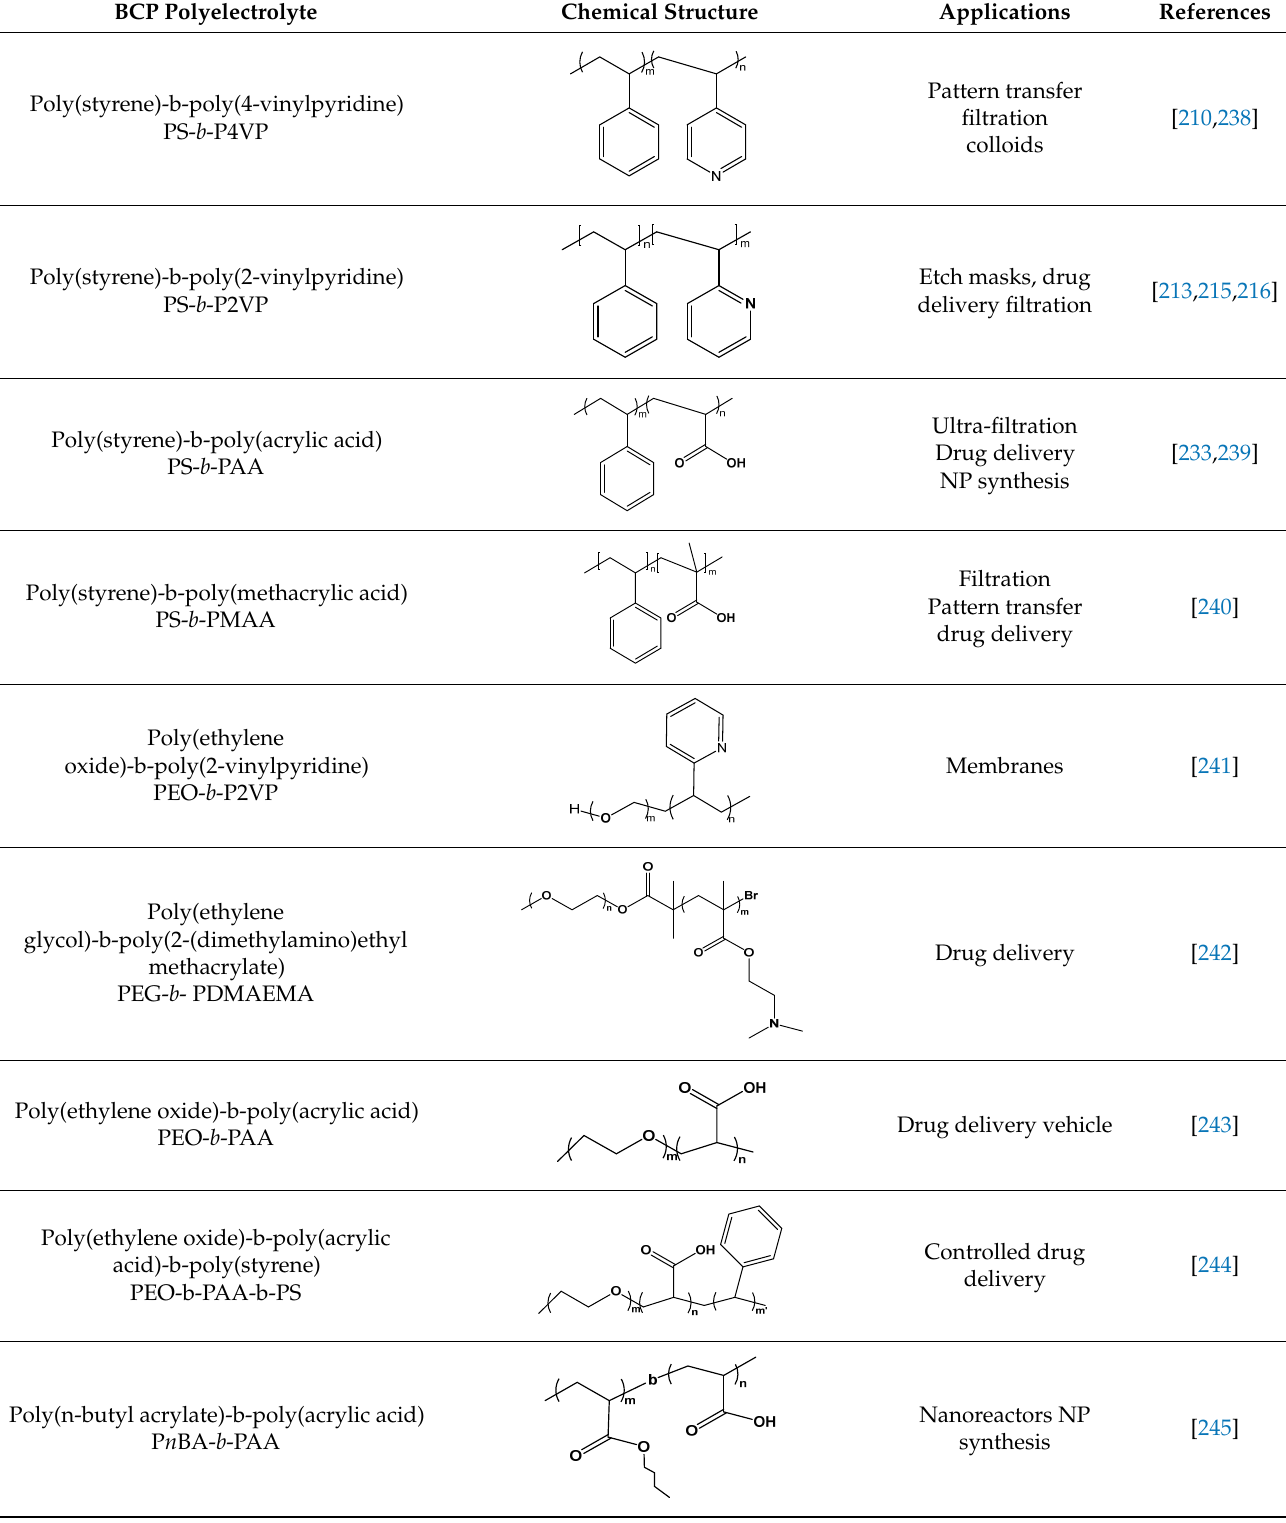
Table 8. Recently reported BCPs containing a weak polyelectrolyte block and their applications.